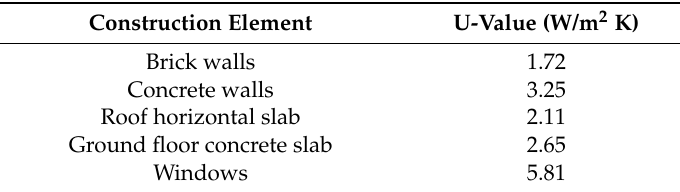
Table 4. Thermal transmittance values calculated for all construction elements of the typical buildings forming the examined urban